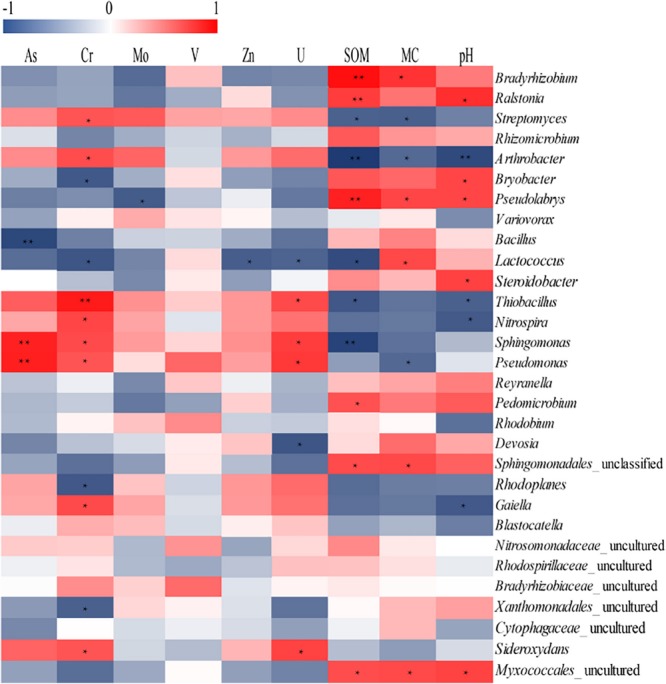
Analysis of correlation between environmental parameters and dominant genera richness. The corresponding values of the heat map is the Pearson correlation coefficient. The value of “r” is between –1 and 1, r < 0 is a negative correlation, r > 0 is a positive correlation, values marked * indicate a significance test at p < 0.05, and values marked ∗∗ indicate a significance test at p < 0.01.